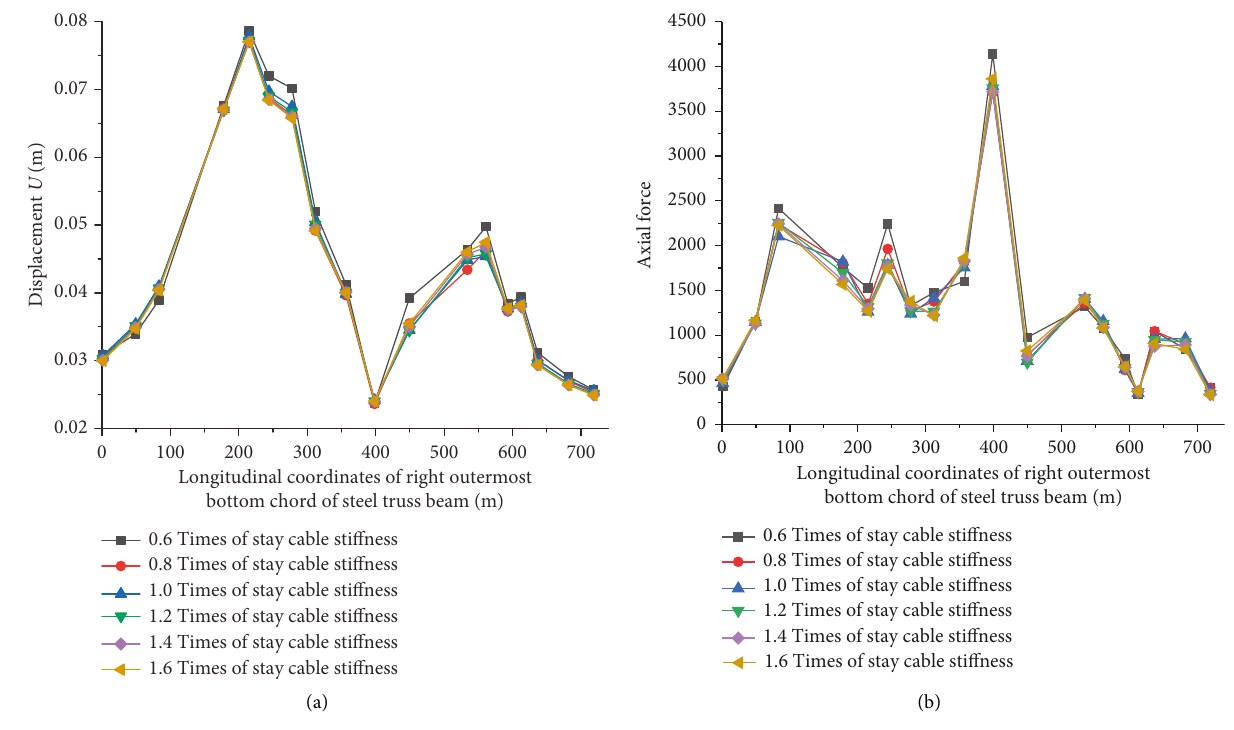
Figure 6: Longitudinal distribution of maximum displacement U and maximum axial force Fx of the bottom chord of the bridge with different multiple cable stiffness under earthquake action. (a) Longitudinal distribution of the maximum values of the displacement and (b) longitudinal distribution of the maximum value of the axial